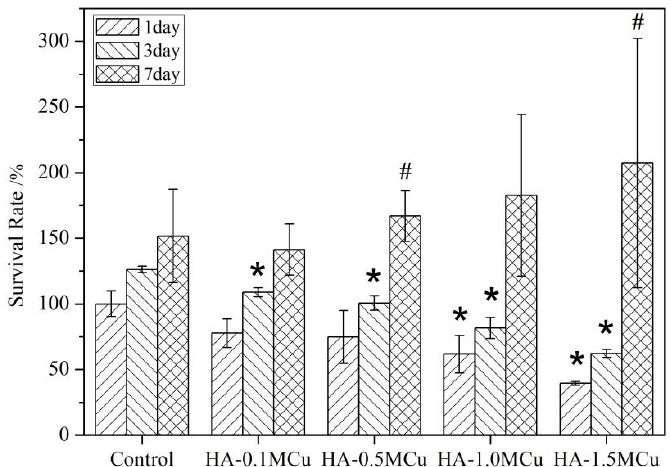
Figure 9. Cell survival rate. (*p < 0.05, compared to control group; #p < 0.05, compared to day 1).